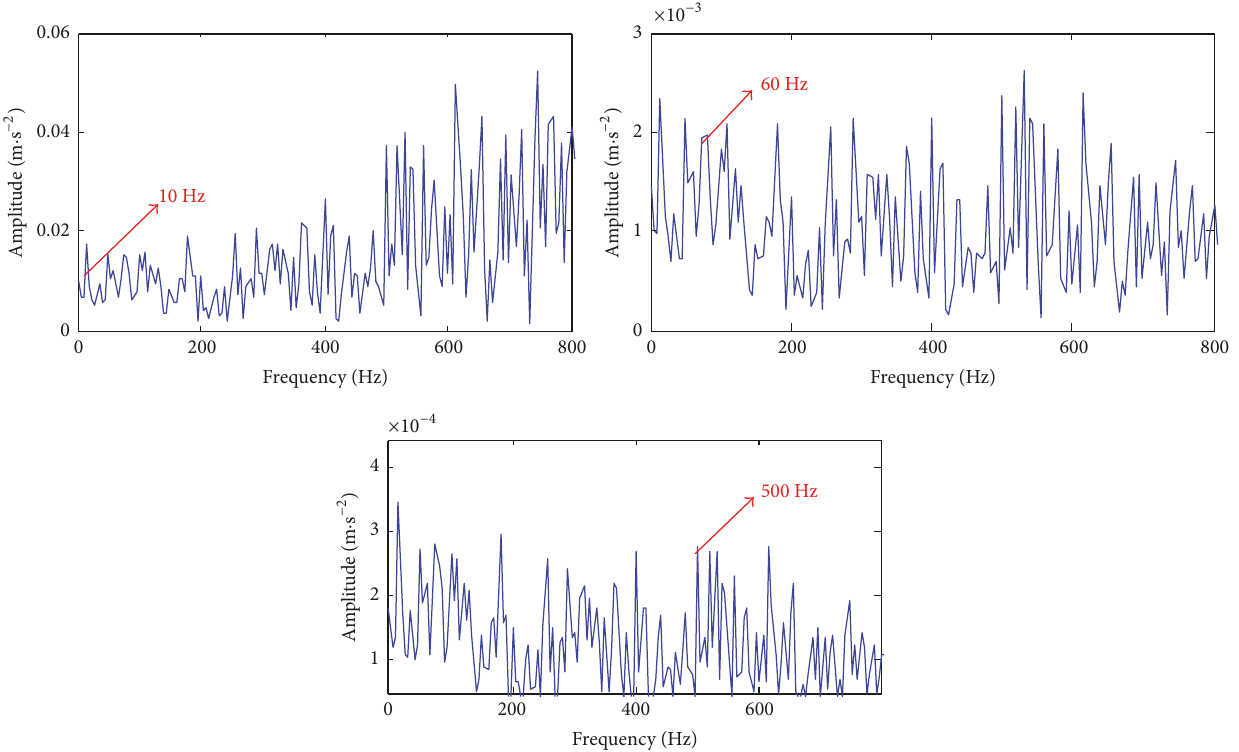
Figure 7: The spectrum of three IMFs through VMD with noise intensity 𝐷 = 2